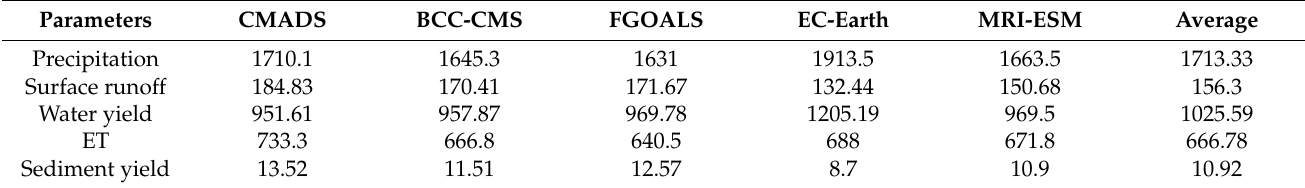
Table 6. Mean values of the actual historical (1981–2014) basin hydrological data simulated using CMADs and GCMs precipitation data.